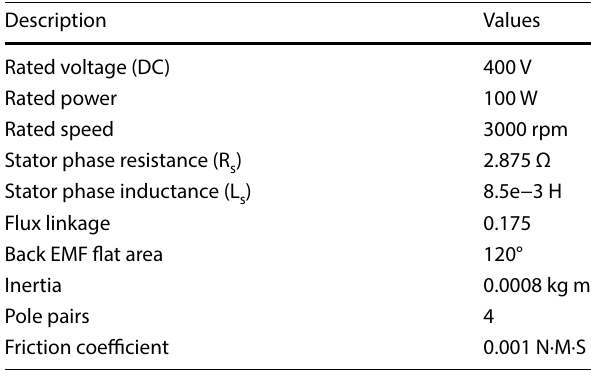
Table 5 Implementation parameters of BLDC